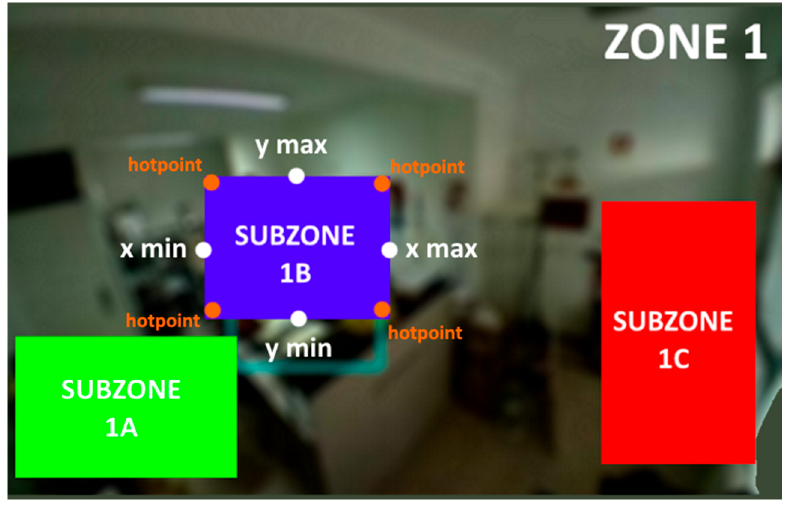
Figure 16. Subzone creation testing.